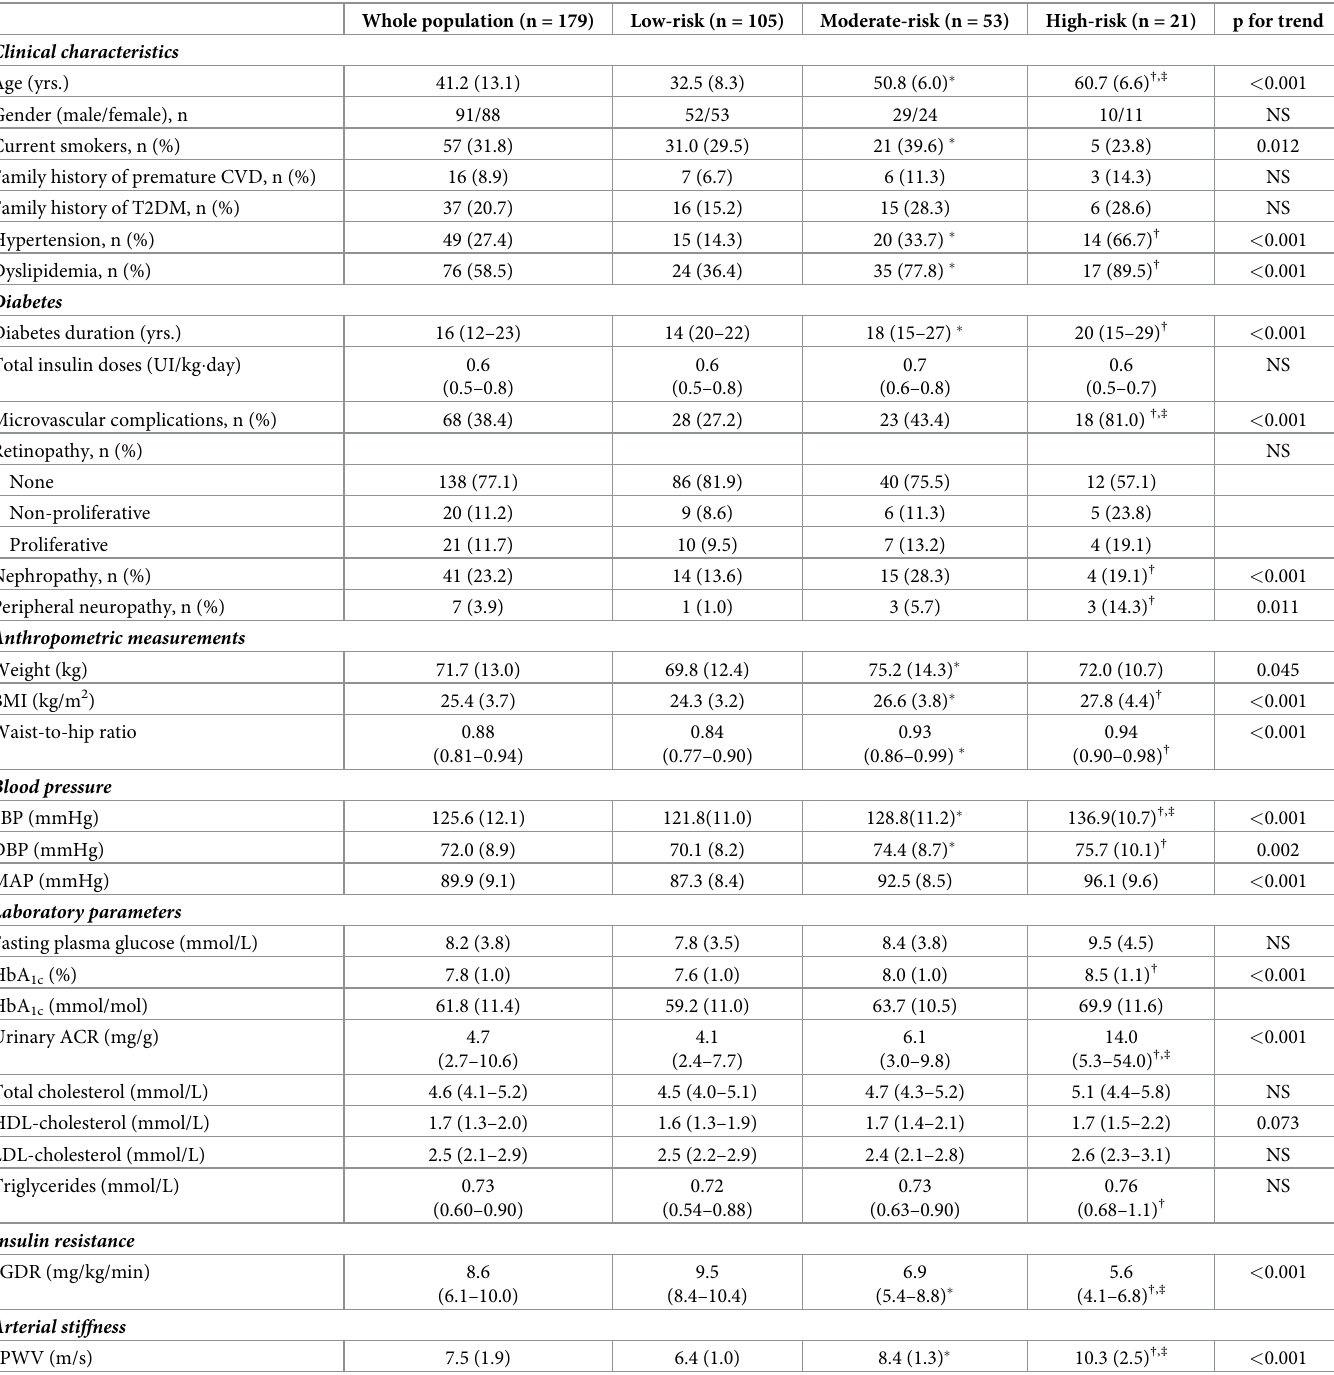
Table 1. Clinical and metabolic characteristics of patients with type 1 diabetes stratified by 10-year CVD risk according to the Steno Type 1 Risk